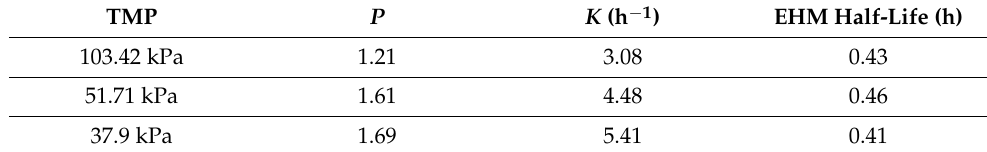
Table 6. EHM parameters for the regressions obtained in Example 2 for CM05 at different TMPs. TMP